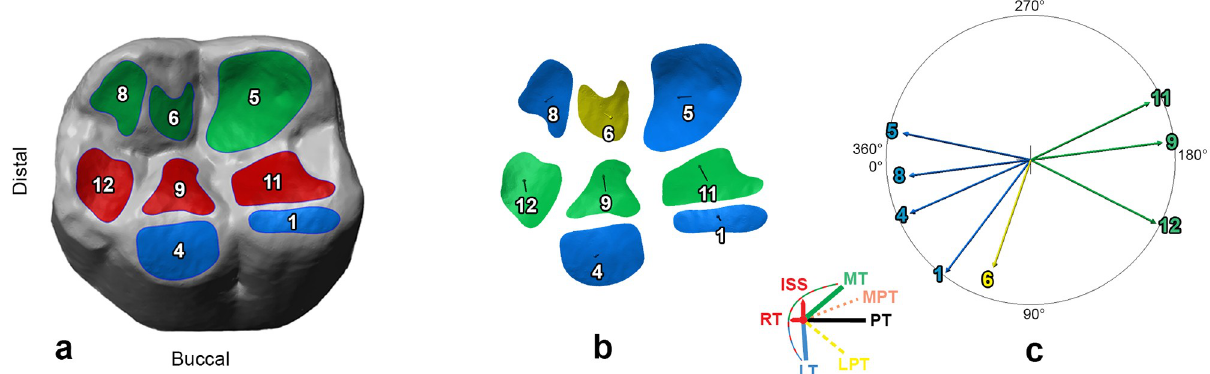
Fig 2. Occlusal fingerprint analysis: Contact areas identification ( a ), directional vectors ( b ), and three-dimensional occlusal compass ( c ). In ( a ) macrowear areas of a first lower permanent molar grouped by chewing cycle phases [31]: Buccal phase I areas (in blue; 1, 1.1, 2, 2.1, 3 and 4), Lingual phase I areas (in green; 5, 5.1, 6, 6.1, 7 and 8), and Phase II areas (in red; 9, 10, 11, 12 and 13). In ( b ) and ( c ) wear areas are colour-coded based on the Dental Occlusal Concept [35], which identifies four major occlusal movements: lateroretrusive (LRT) areas (in blue; 1, 1.1, 5, 5, 5.1 and 8), lateroprotrusive (LP) areas (in yellow; 2, 2.1, 3, 6, 6.1 and 7), mediotrusive and immediate side shift (MT + ISS) areas (in green; 9, 11 and 12), and medioprotrusive (MPT) areas (in orange; 10 and